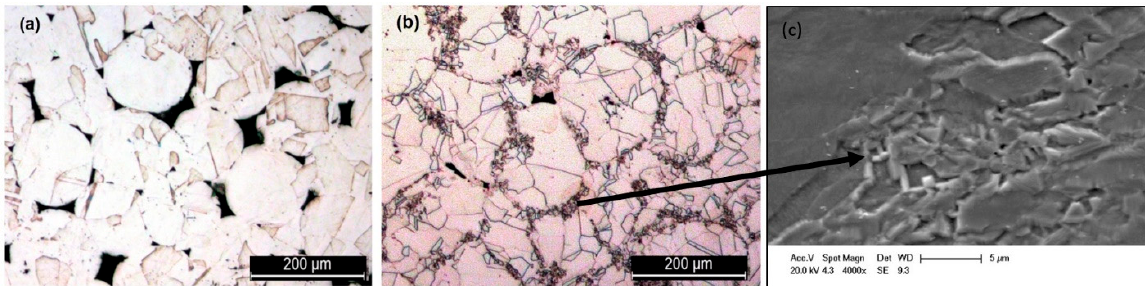
Figure 1. Sintered samples IP ( a ) and MM ( b ) nickel; ( c ) shell area at higher magnification.